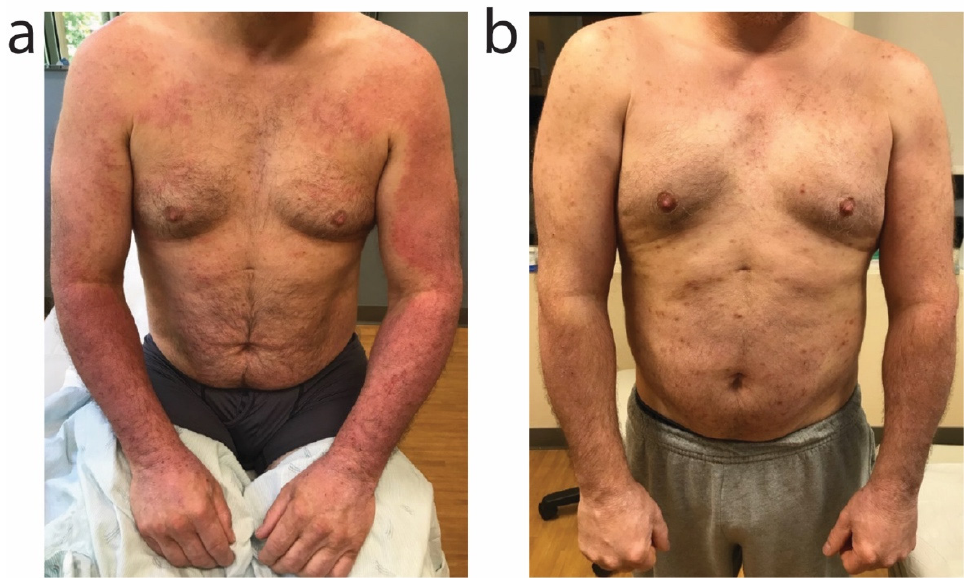
Figure 4 . Impetiginized atopic dermatitis improved with oral sarecycline. Impetiginized atopic dermatitis of the bilateral upper extremities moreso than the chest and abdomen ( a ) improved after sarecycline 150 mg daily for 9 days ( b ).